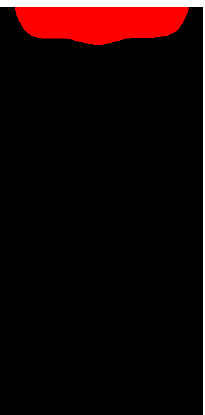
Figure 13. The area where the nozzle is located when there is no